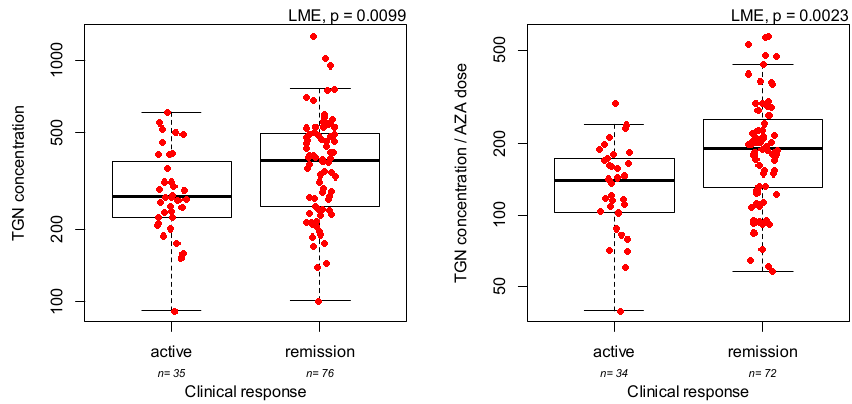
Figure 1. Response to azathioprine (AZA) and thioguanine nucleotides (TGN) concentration, as pmol / 8 × 10ˆ8 erythrocytes (left panel) or ratio between TGN concentration / daily azathioprine dose as pmol / 8 × 10ˆ8 erythrocytes / mg / kg / day (right panel). p -values are from linear mixed e ff ect model (LME). On the contrary, azathioprine dose and the concentration of MMPN metabolites were not associated with a clinical response (data not shown).